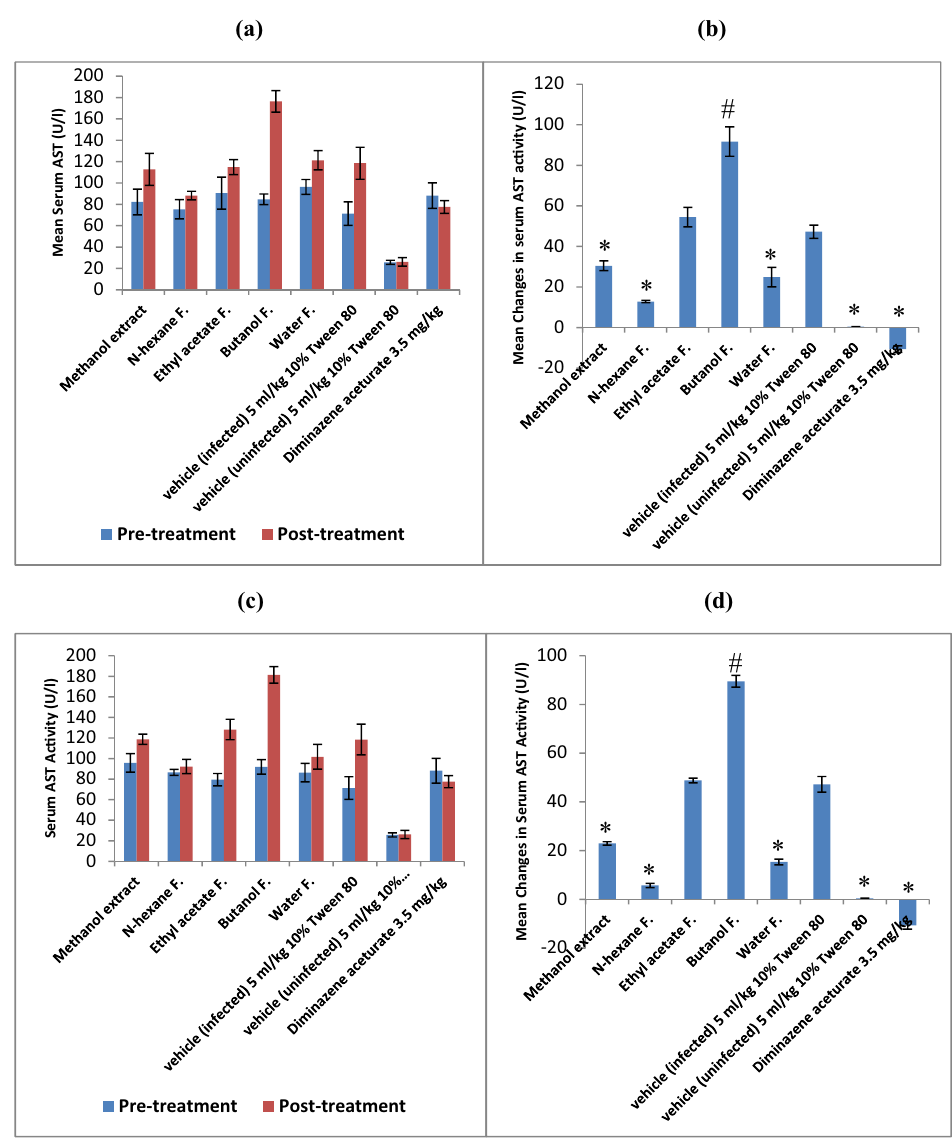
Figure 6: E ff ect of extract and fractions on serum AST activity of T. brucei brucei - infected animals. ( a ) 200 mg/kg extract and fraction e ff ect on AST activity; ( b ) 200 mg/kg extract and fraction e ff ect on mean changes in AST activity; ( c ) 400 mg/kg extract and fraction e ff ect on AST activity; and ( d ) 400 mg/kg extract and fraction e ff ect on mean changes in AST activity. * P < 0.05 compared to the vehicle - infected control group ( signi fi cant decrease ) and # P < 0.05 compared to the vehicle - infected control group ( signi fi cant increase )